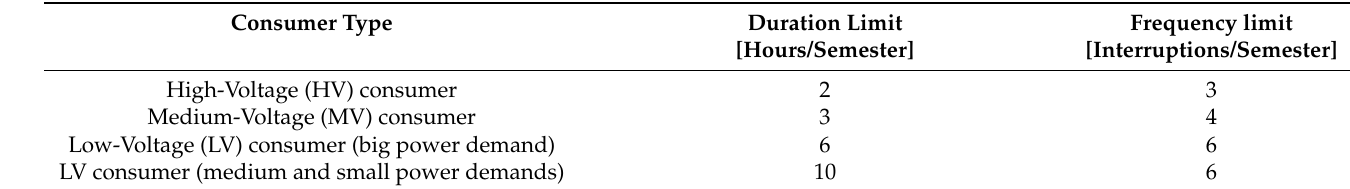
Table 2. Individual continuity limits in Argentina.